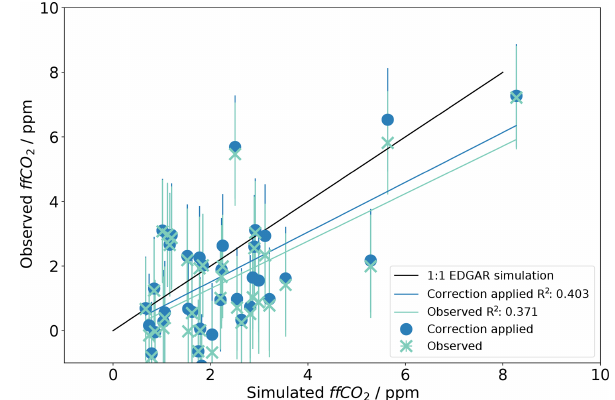
Figure 4. Comparison of fossil fuel CO 2 (observed ffCO 2 ) derived from (cid:49) 14 CO 2 measurements made at TAC (Sect. 3.3, Eq. 4) com- pared to simulated ffCO 2 . The simulated ffCO 2 was calculated from NAME model back trajectories and the EDGAR 2010 fossil fuel emission inventory according to Sect. 3.1. Observations that have been corrected for nuclear (Sect. 3.3.2) and biospheric (Sect. 3.3.1) influences are shown as blue points, whereas the uncorrected values are shown as green crosses. The 1 : 1 line shown in black represents the theoretical line where observed data match the simulated values and therefore the emission inventory exactly. The linear regression lines for the comparison of the modelled ffCO 2 to the corrected and uncorrected observed ffCO 2 are shown as blue and green lines, re- spectively. Error bars are